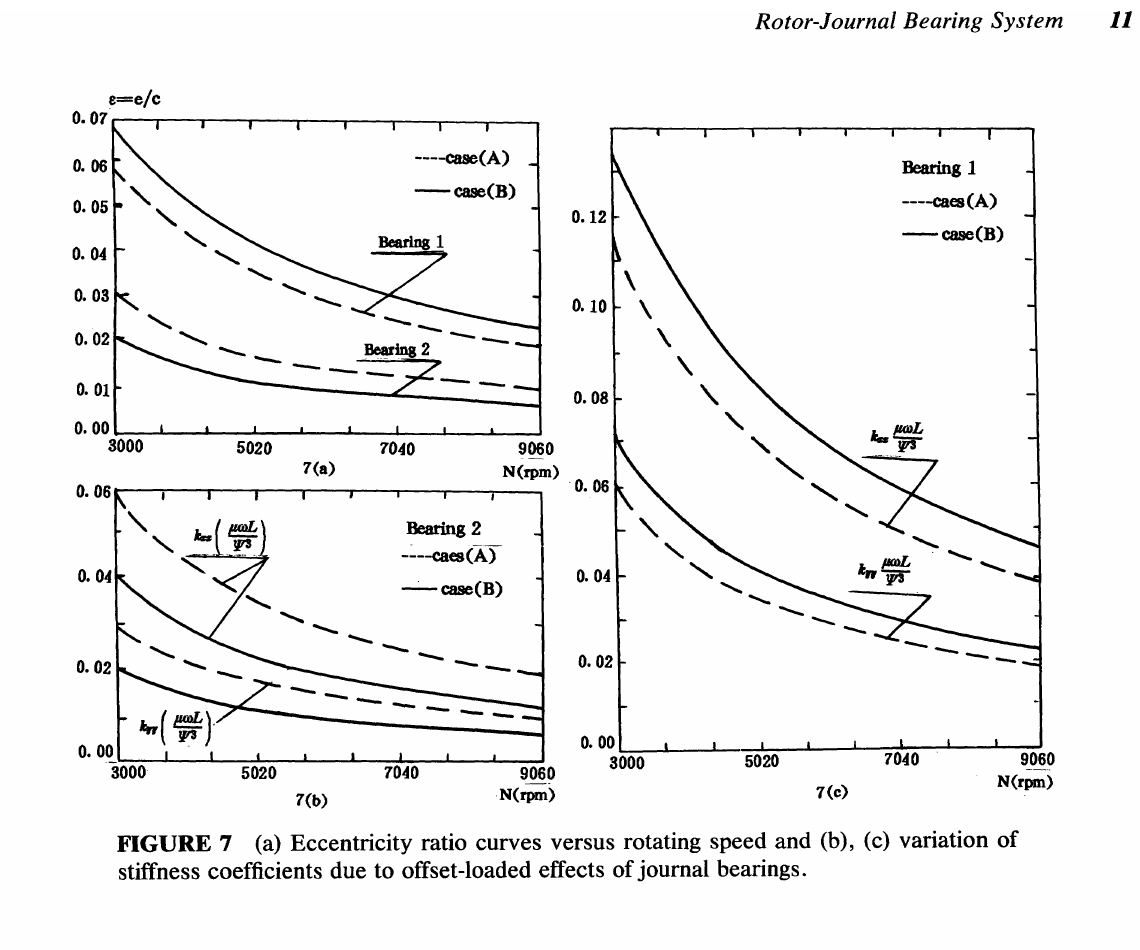
FIGURE 7 (a) Eccentricity ratio curves versus rotating speed and (b), (c) variation of stiffness coefficients due to offset-loaded effects of journal bearings.